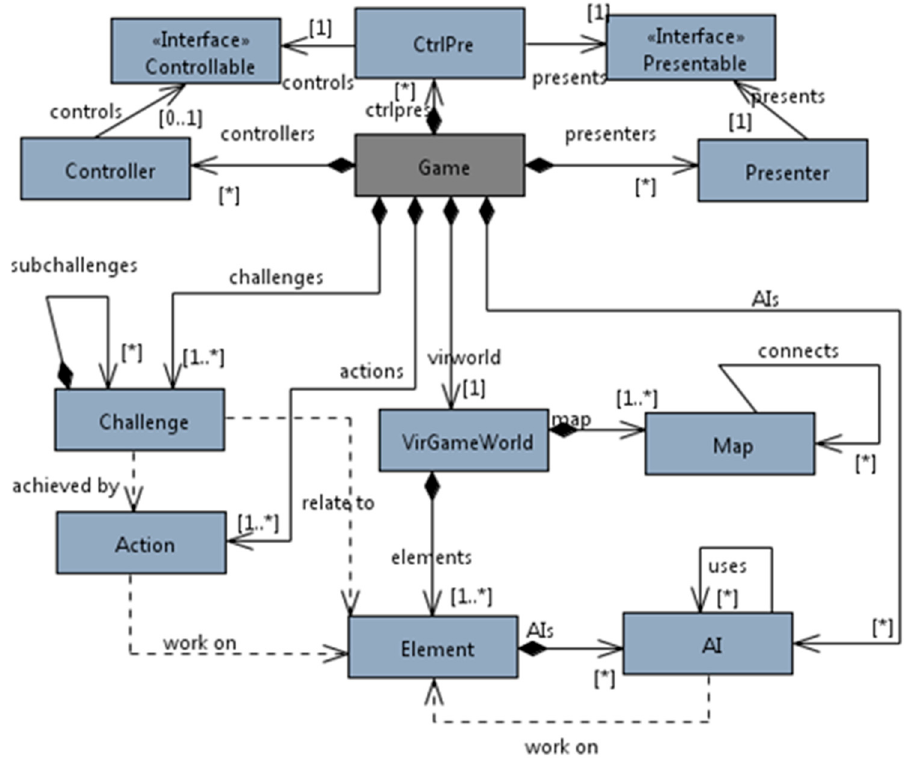
Figure 2. The core part of Pervasive Game Ontology